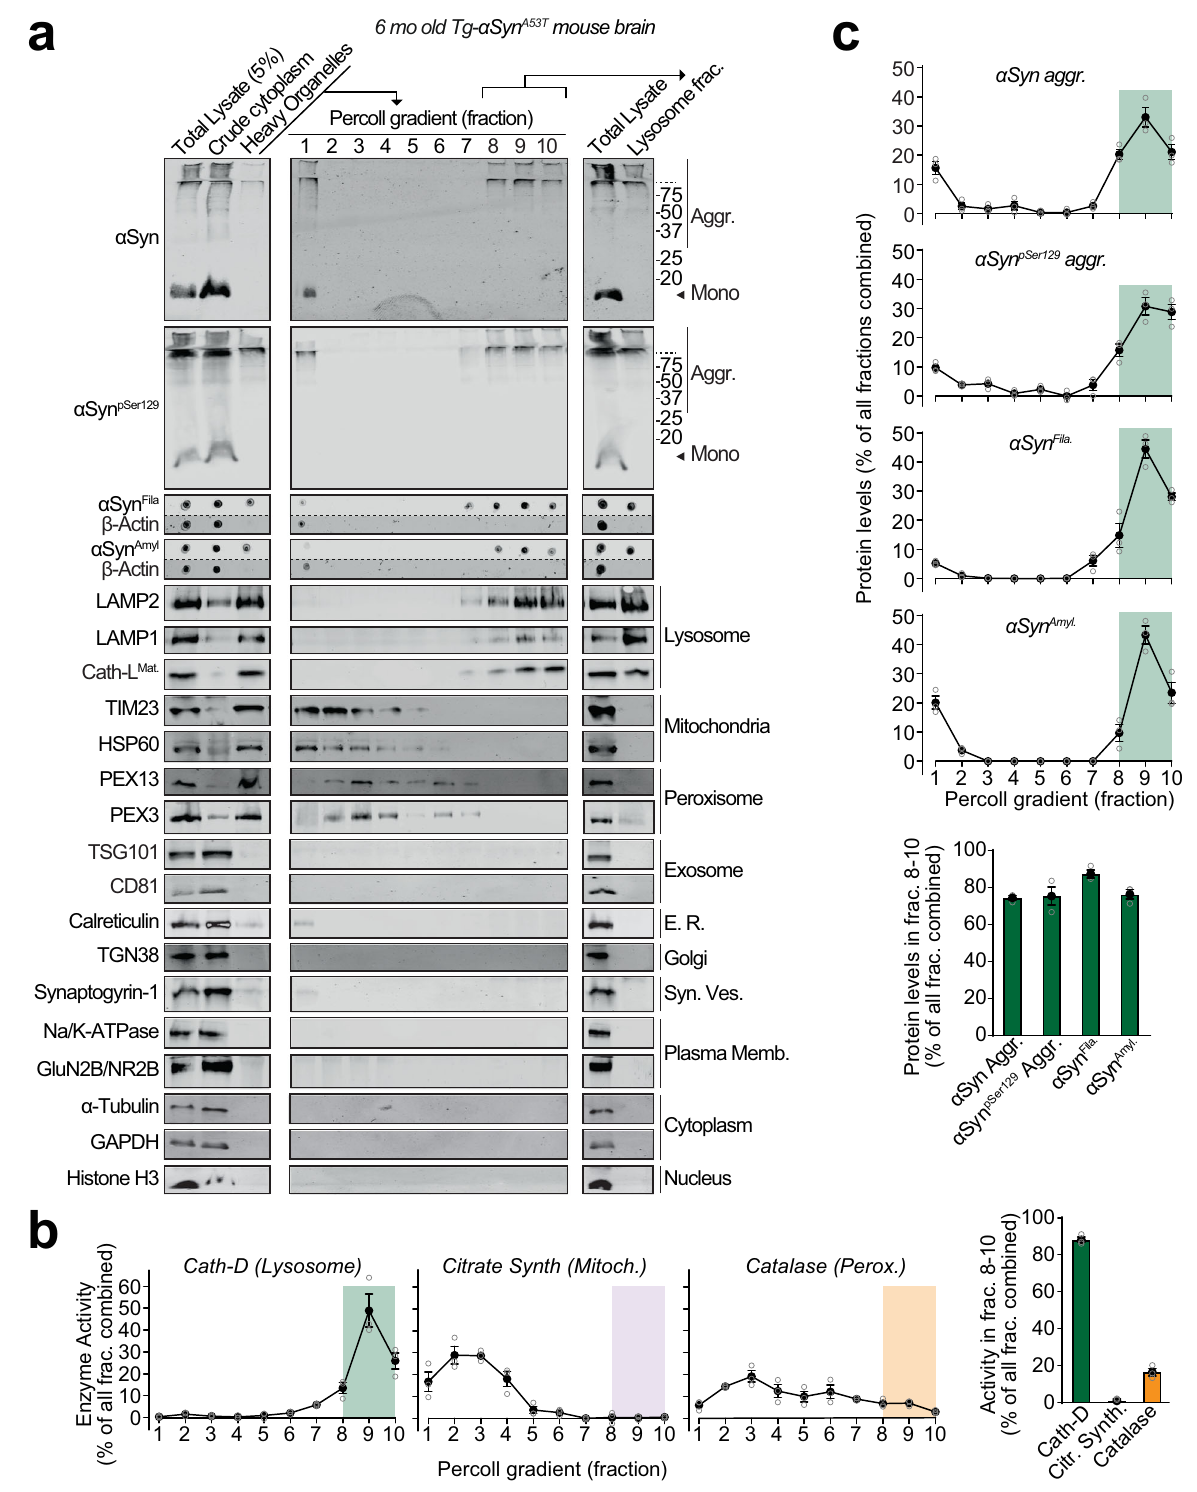
Fig. 1 | Pathogenic α Syn aggregates accumulate within lysosomes of aged Tg- α Syn A53T mice. Lysosomes were isolated from 6-month-old Tg- α Syn A53T mouse brains via Percoll gradient centrifugation of the heavy organelle fraction — which contained peroxisomes, heavy lysosomes loaded in vivo with dextran-70, and mitochondria swollen ex vivo by CaCl 2 . a Lysosome (dextranosome) enrichment wasdeterminedbyimmunoblottingformarkersofindicatedorganelles,compared to the respective levels in the total lysate input. Membrane-matched dot blots ( β - Actin=loading control) are separated by dashed lines. b Left panels — Activities of enzymes contained within lysosomes (cathepsin-D), mitochondria (citrate